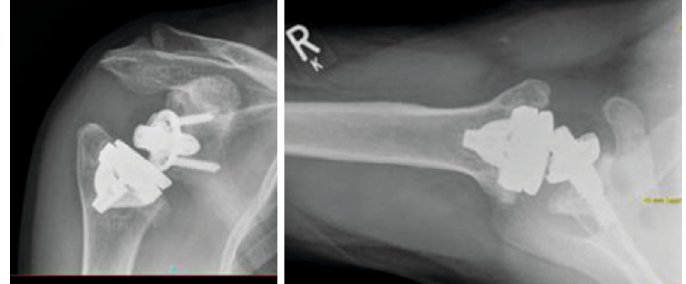
Figure 5: Eight weeks post-op.